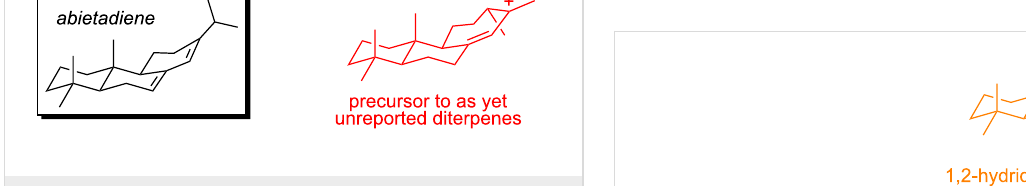
Figure 9: Carbocation rearrangements involved in abietadiene forma- tion.